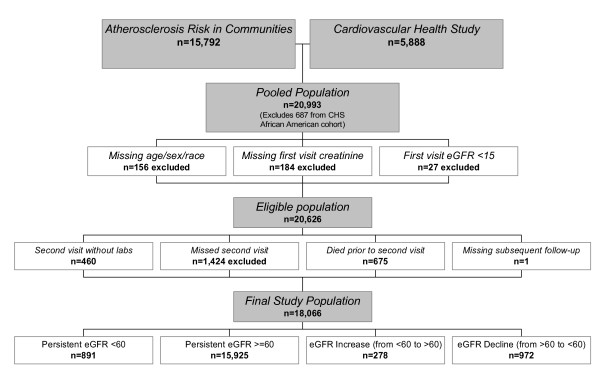
Derivation of the study population. eGFR, estimated glomerular filtration rate in mL/minute per 1.73m2.